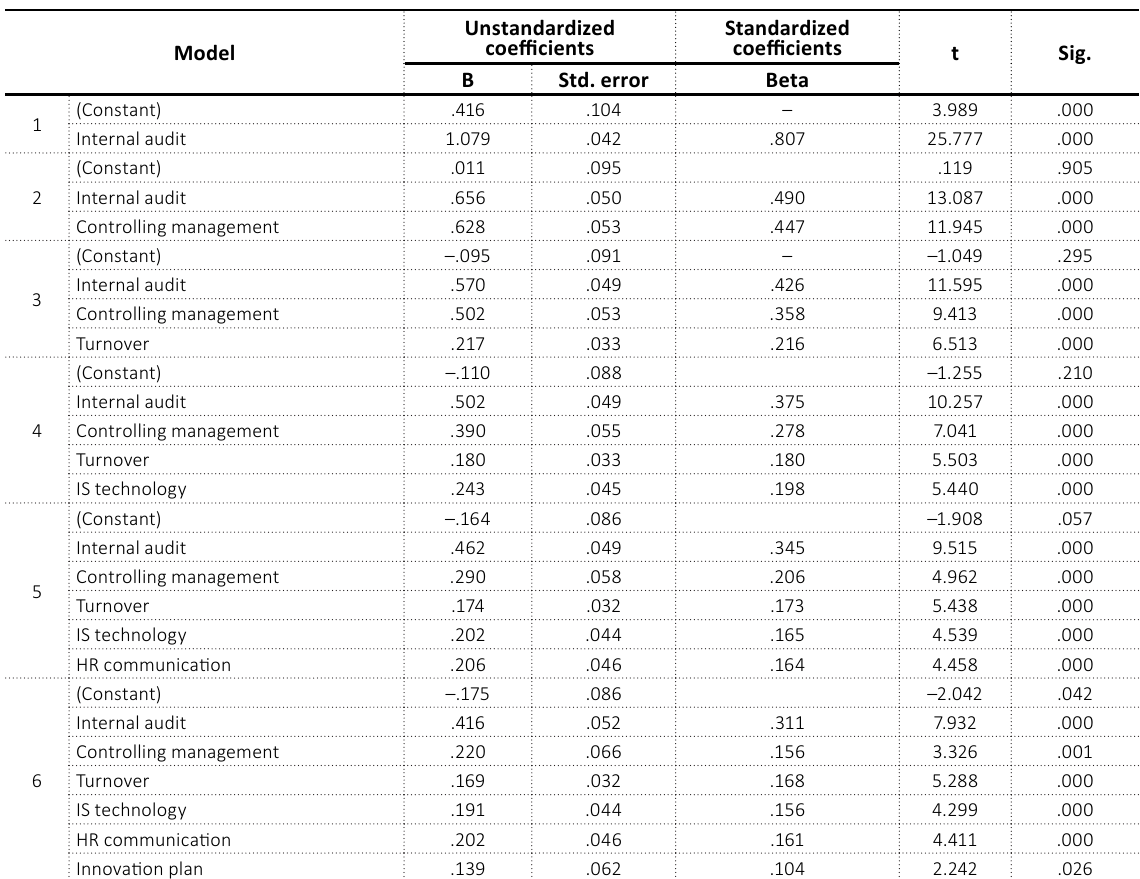
Table 2. Inclusion in the final model